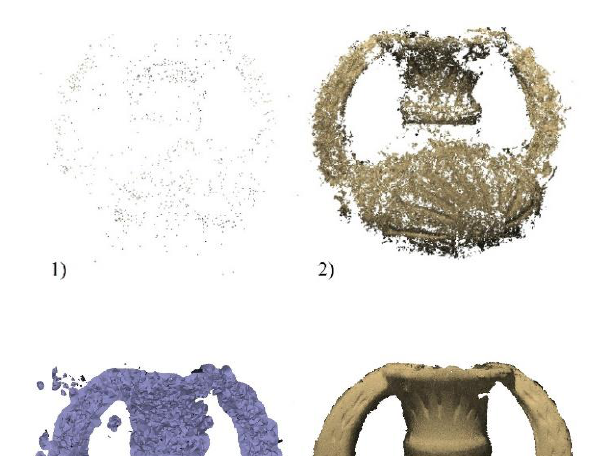
Figure 4. The schematic image of hologram photogrammetry from two levels of camera height.